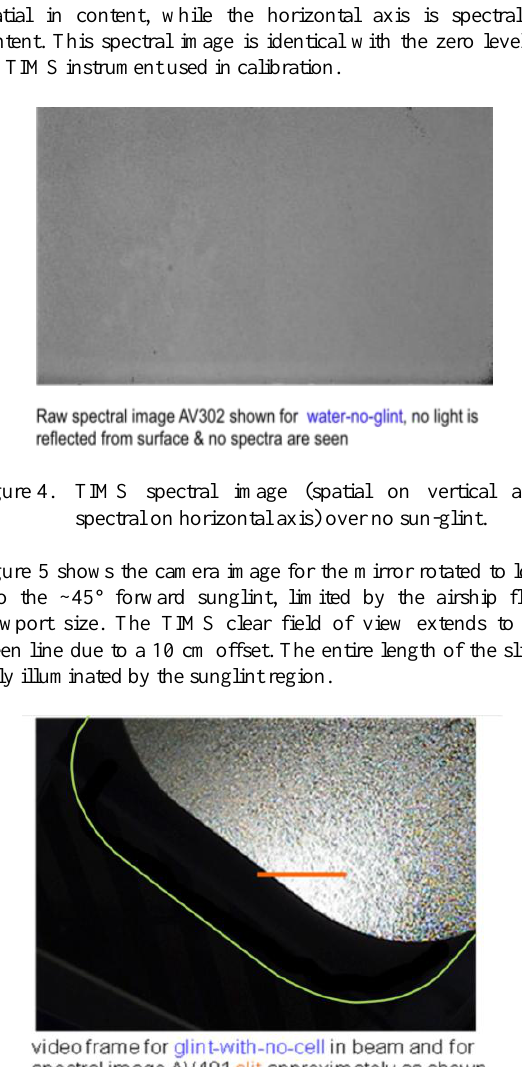
Figure 5. Spectral image region outline over the camera image over sunglint